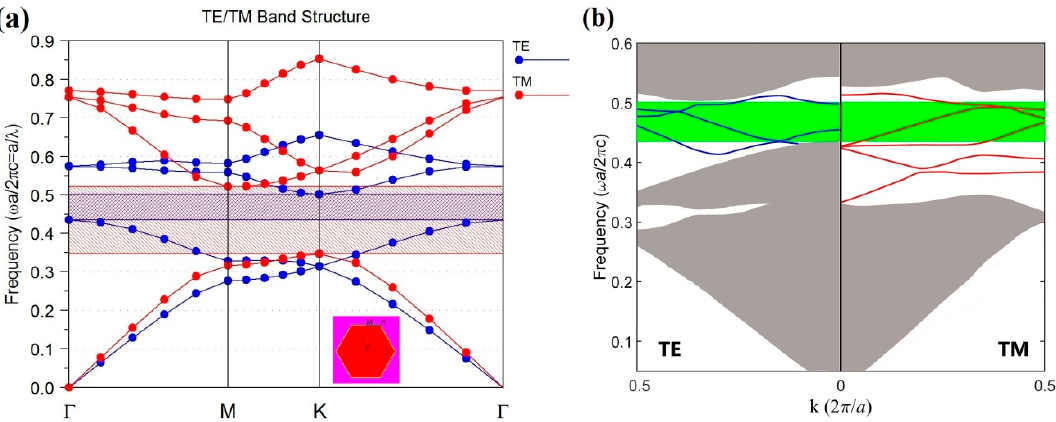
Figure 2. ( a ) Band structure of a perfect 2D triangular-lattice photonic crystal (PhC), where the blue, red, and common regions represent the TE, TM, and absolute photonic bandgap (PBG), respectively. ( b ) The dispersion curves of the guided modes in the input and output waveguides. The blue and red curves indicate the TE- and TM-guided modes, respectively. The green and gray regions indicate the absolute PBG and passband of PhC, respectively.